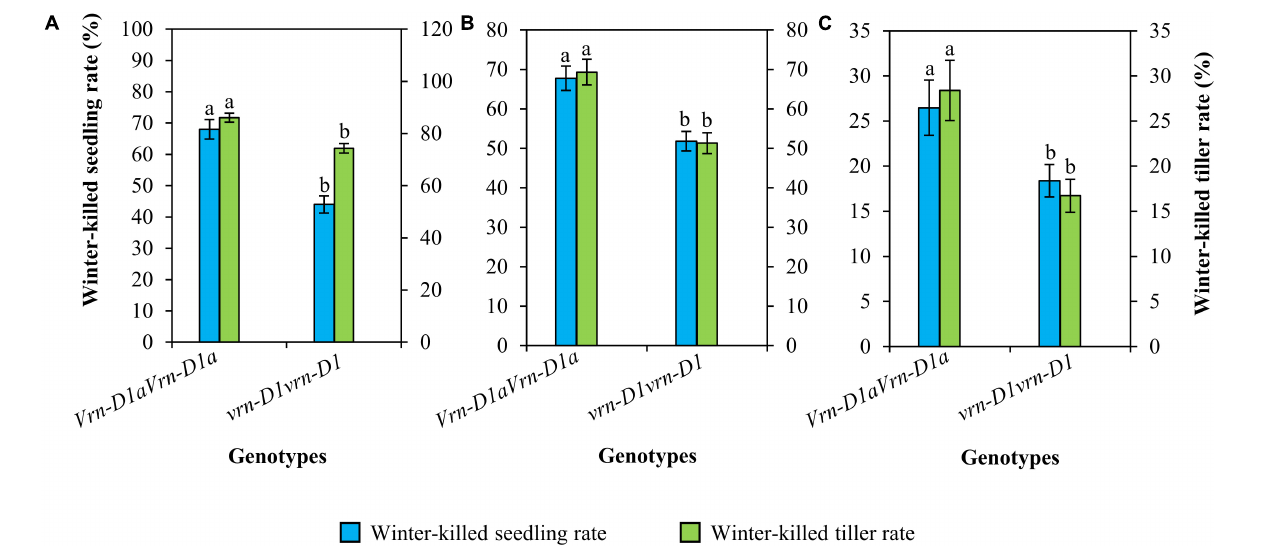
FIGURE 4 | Comparison of winter frost tolerance between genotypes vrn-D1vrn-D1 ( n = 60) and Vrn-D1aVrn-D1a ( n = 50) in the panel of wheat cultivars at 2021SY (A) , 2021DX (B) , and 2021TG (C) . Differences in winter frost between genotypes for each trait were determined by the t -test and different letters above the error bars indicate a significant difference at P < 0.05.